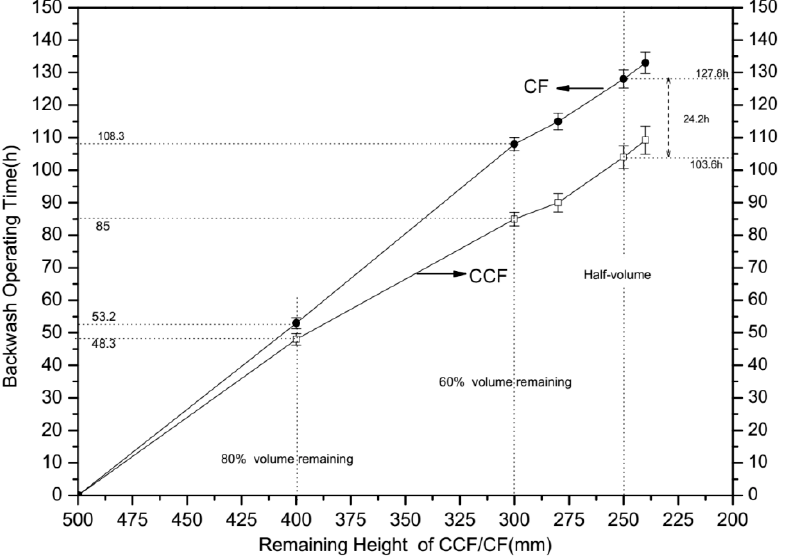
Figure 7. the half-volume test of CCF and CF. Figure 7. The half-volume test of CCF and